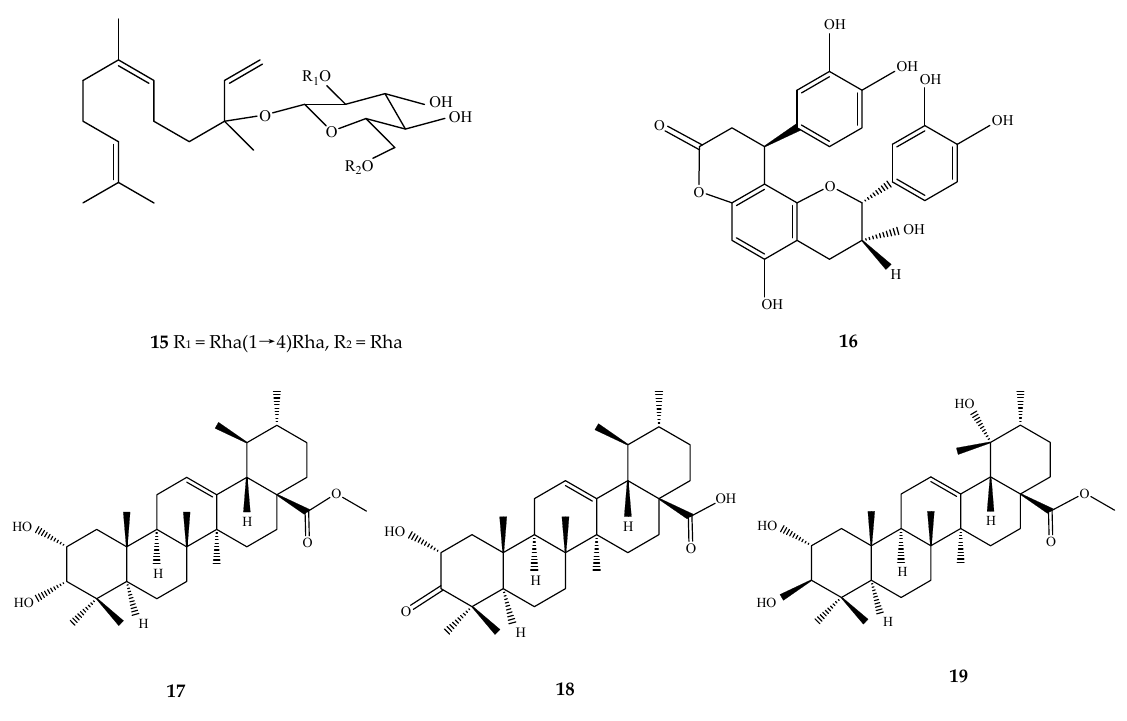
Figure 2. Structures of chemical compounds 15 – 19 . 15 : nerolidol-3- O - α - L -rhamnopyranosyl(1,4)- α - L -rhamnopyranosyl(1,2)-[ α - L -rhamnopyranosyl(1,6)]- β - D -glucopyranoside; 16 : cinchonain Ib; 17 : 3-epicorosolic acid methyl ester; 18 : 2- α hydroxy-3-oxo urs-12-en-28-oic acid; 19 : tormentic acid methyl ester.